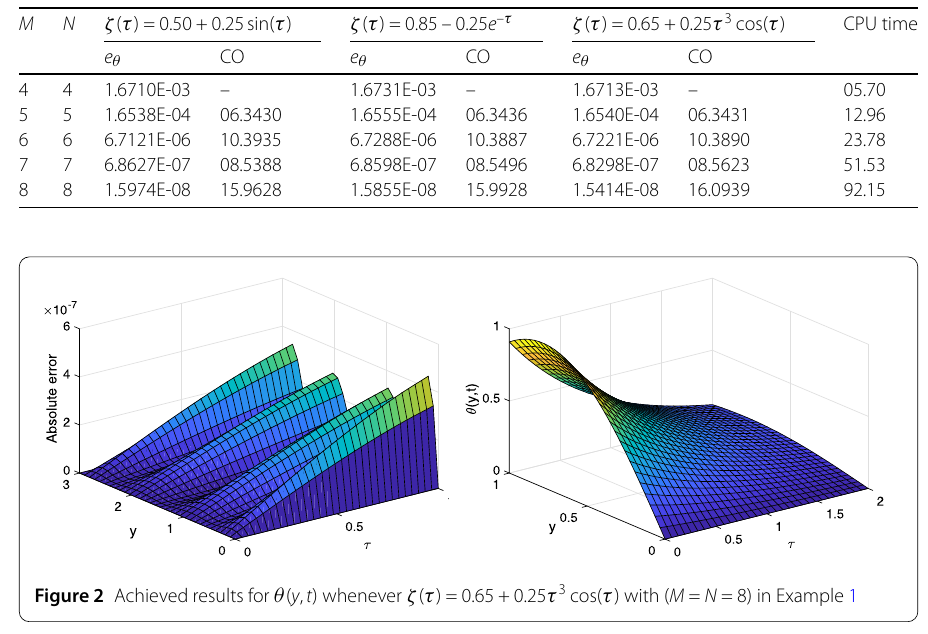
Figure 2 Achieved results for θ ( y , t ) whenever ζ ( τ ) = 0.65 + 0.25 τ 3 cos( τ ) with ( M = N = 8) in Example